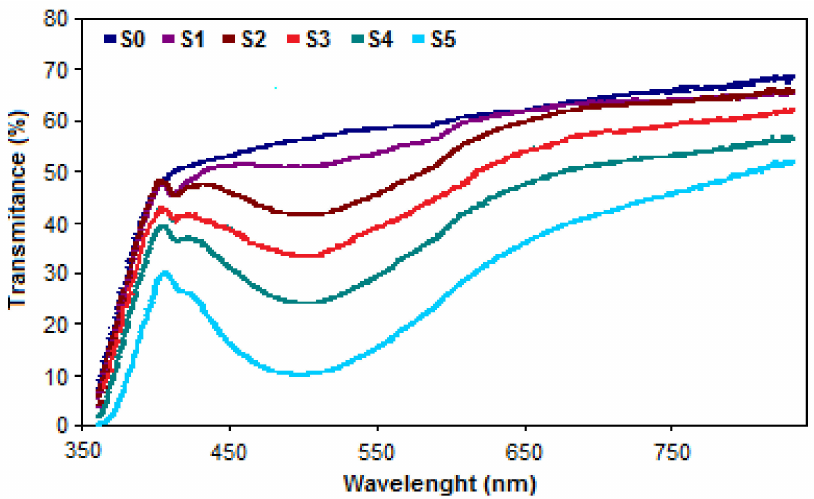
Figure 2. UV–VIS spectra of the obtained agriglass